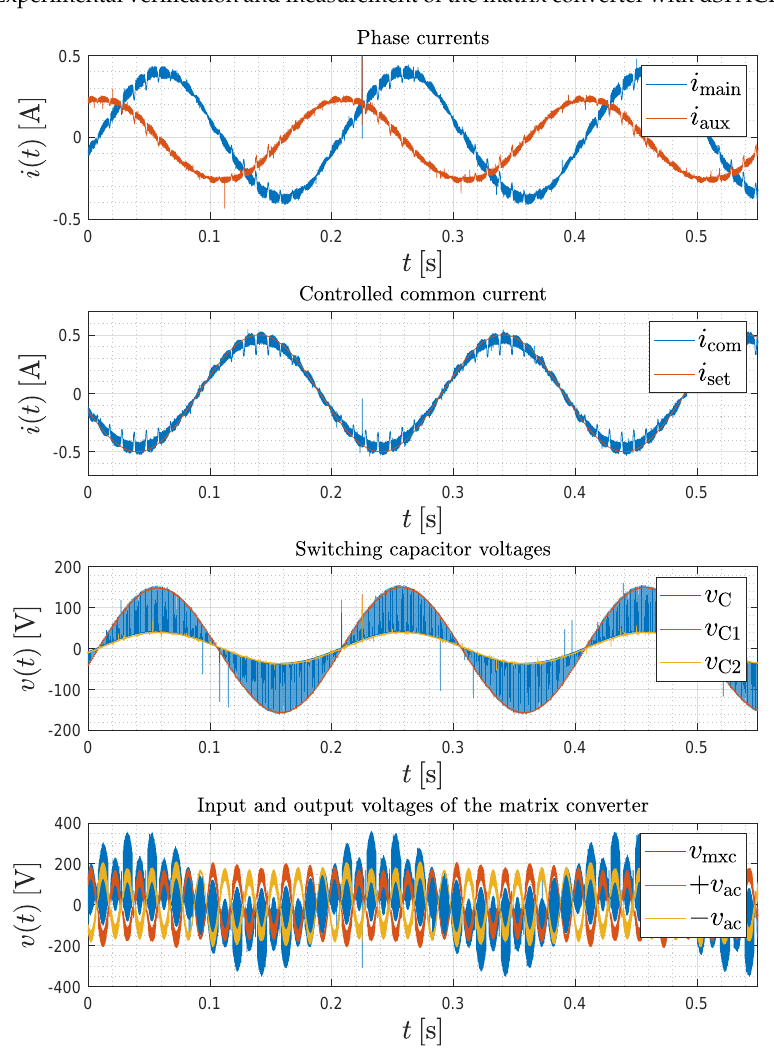
Figure 24. Measured variables of feedback control at a frequency of 5